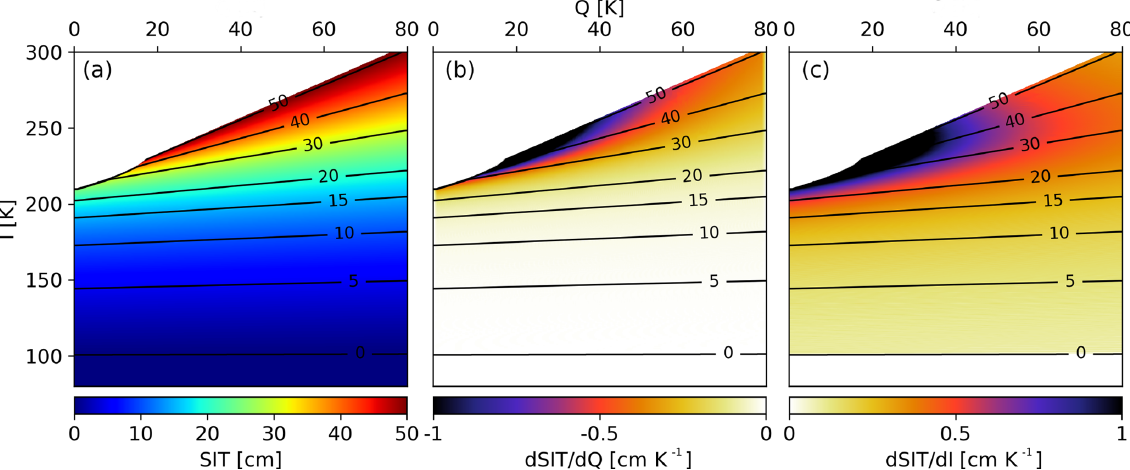
Figure 8. SIT (a) computed with the 40 ◦ TB algorithm (Fig. 1, red curve) represented in the space of Q and I . Derivative of SIT as a function of Q (b) and I (c) . The black lines in all three figures represent the isolines of the SIT derived from panel (a)